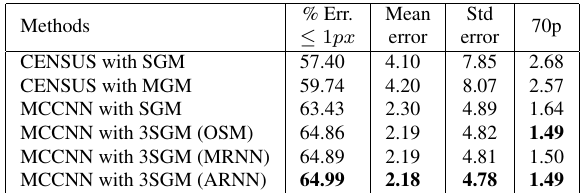
Figure 7. DSMs computed on London (UK) with different optimizations. ARNN errors do not impact